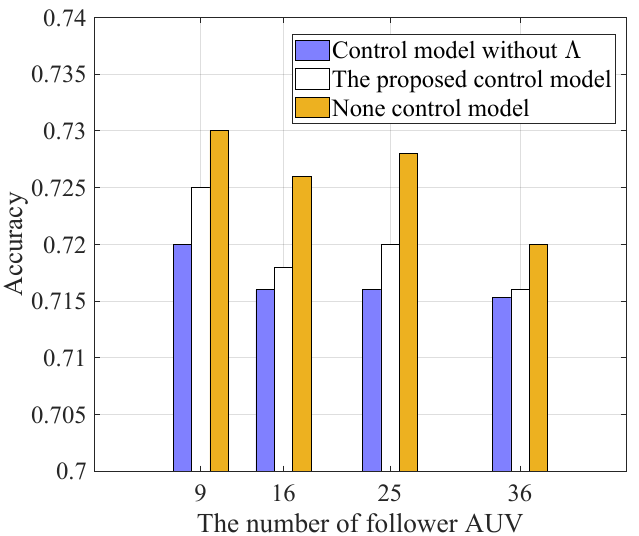
Figure 5. Comparison of the accuracies of different control models versus the number of follower